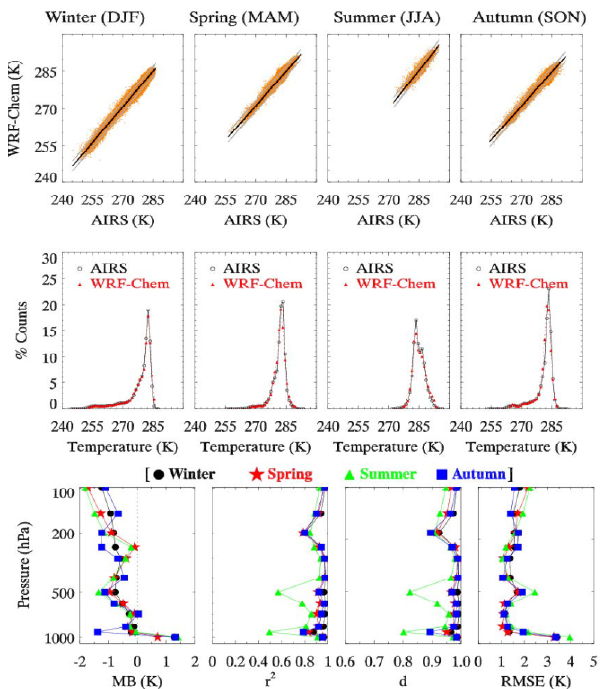
Figure 5: The scatter plots (top panel) and the frequency analyses (middle panel) of AIRS and simulated temperature at 2 K interval for 700 hPa during the four seasons of the year 2008. The black lines in the scatter plots represent the linear fit to the data while the grey lines are the 95% confidence interval estimates in the fitted values. The vertical profiles (bottom panel) of mean bias (MB), coefficient of determination (r 2 ), index of agreement (d) and root mean square error (RMSE) for each season are also shown.